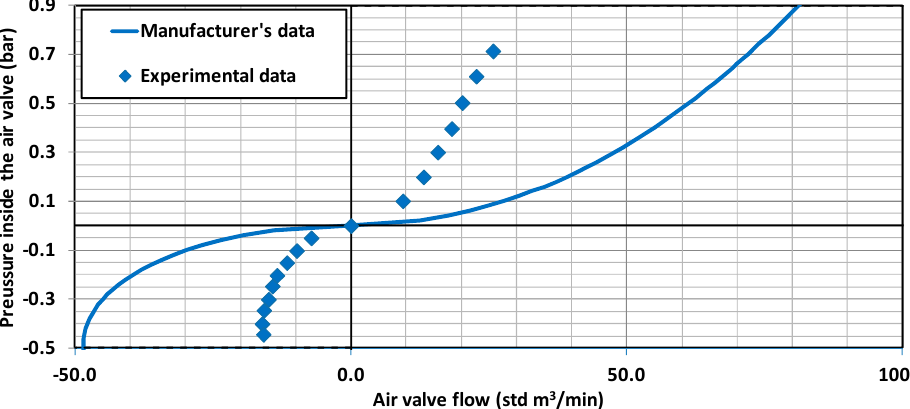
Figure 3. Comparison between laboratory tests and information provided by a manufacturer.